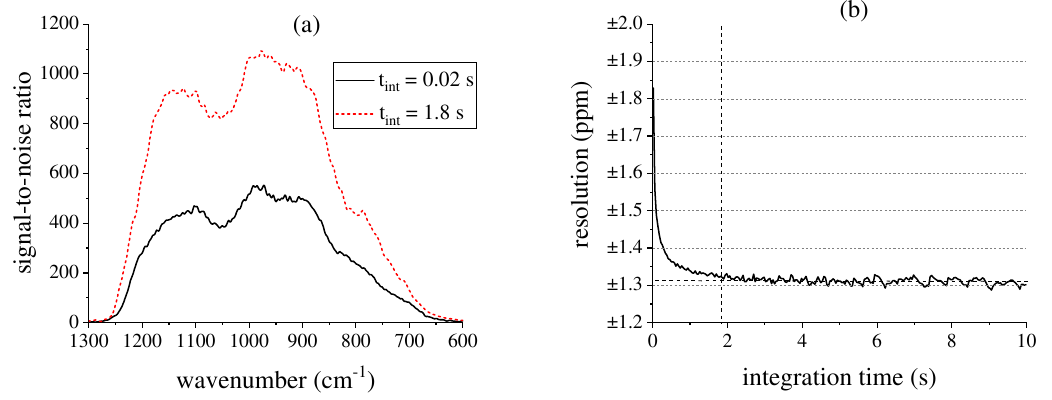
Figure 7. ( a ) Background signal-to-noise ratio (SNR) of the measurement system for different integration times t int at a measurement frequency of 50 Hz; ( b ) Corresponding resolution of the system for a of 100 ppm R134a